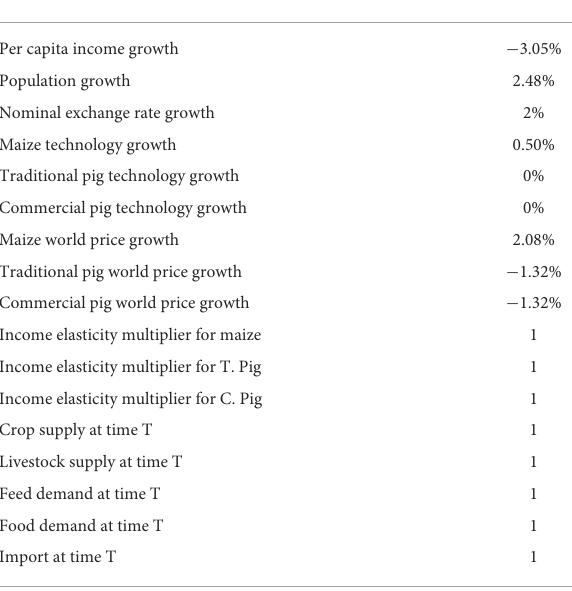
TABLE 2 Factor growth assumptions from the baseline.